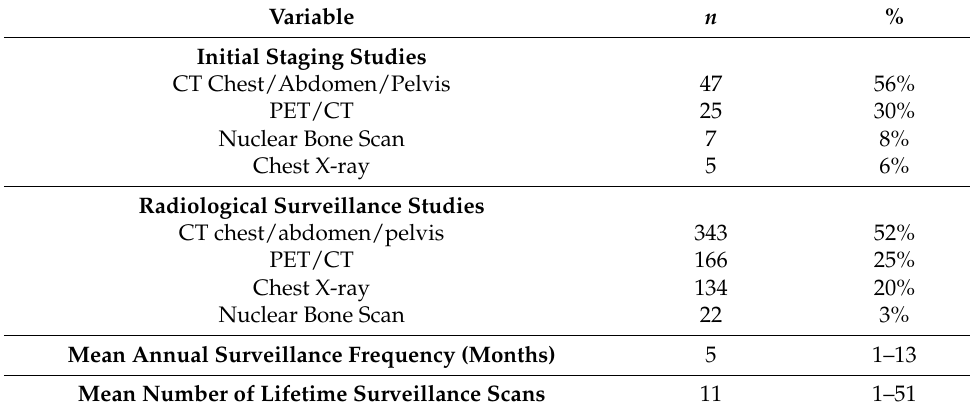
Table 4. Radiological Staging and Surveillance